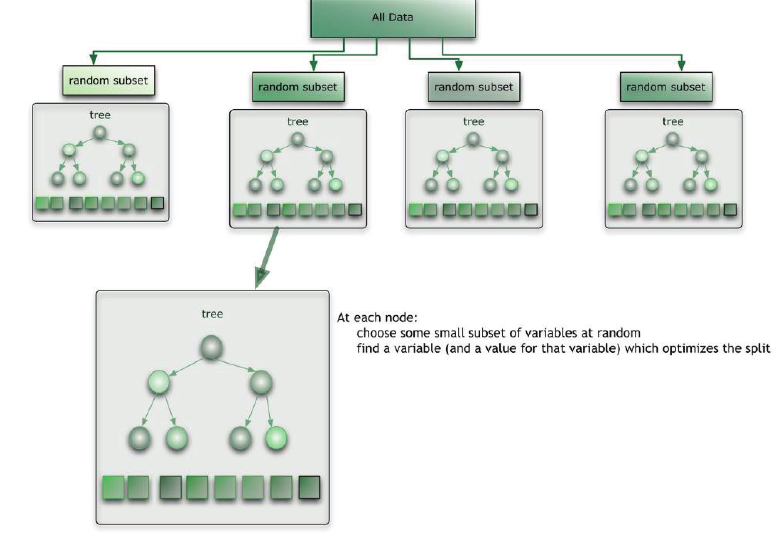
Fig. 5. Random Forest (CitizenNet and Blackwell, A.,